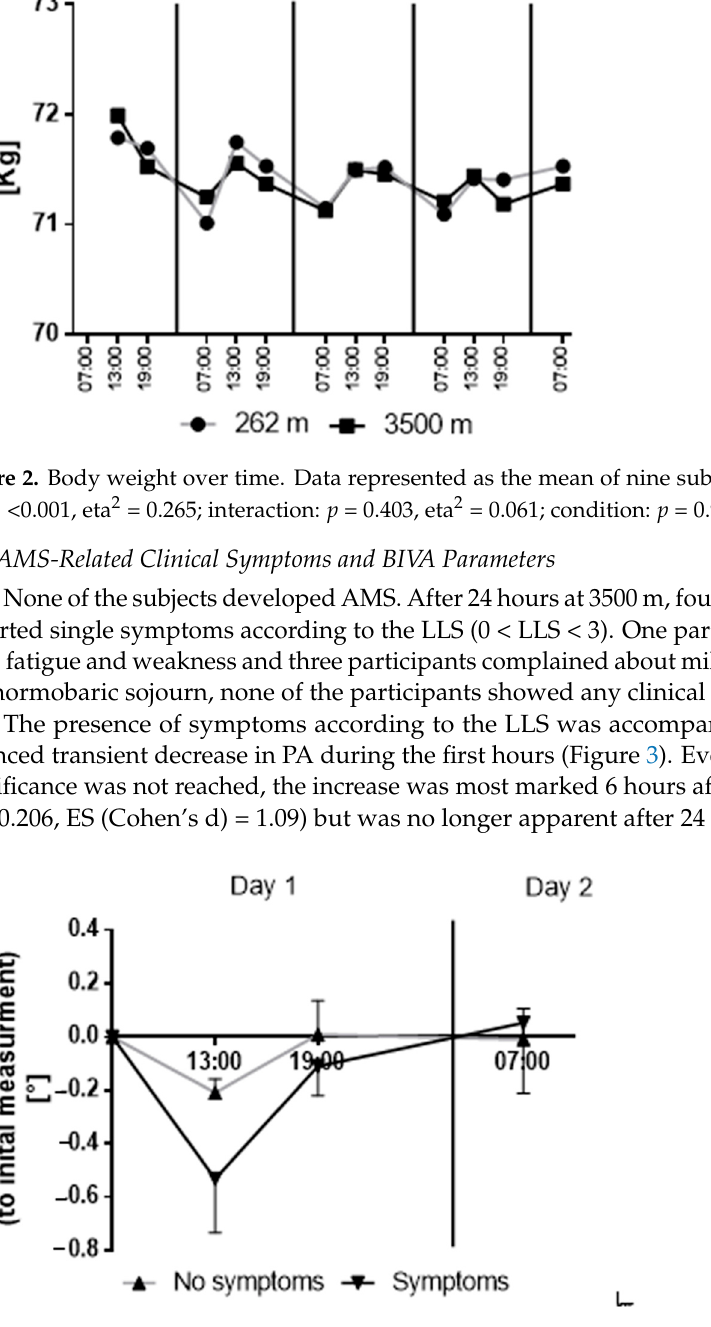
Figure 3. Change in phase angle (PA) from the initial value after simulated ascent . Data from 5 subjects without symptoms are represented with a gray line and upwards-pointing triangles ( ▲ ). Data from 4 subjects with symptoms are represented with a black line and downwards-pointing triangles ( ▼ ). Data represented as mean and standard error of mean (error bars). Unpaired t-test with Welch’s correction used to analyze changes within the first 6 hours: p = 0.206; ES Cohen’s: d = 1.09.